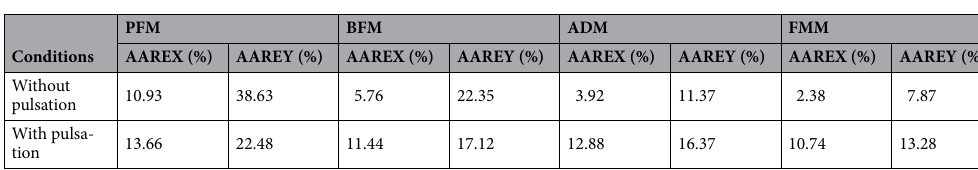
Table 3. Comparison of the AARE values between PFM, BFM, ADM, and FMM models.